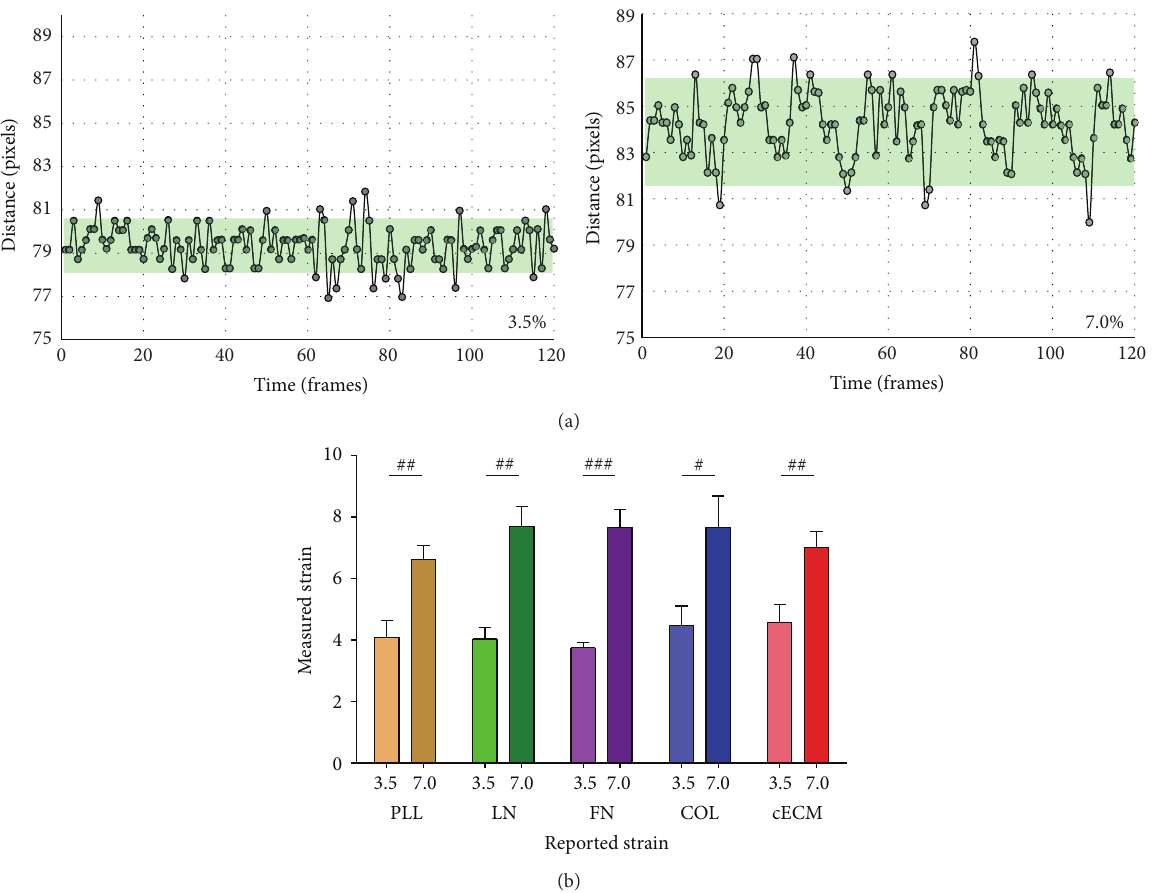
Figure 1: Cell strain. CPCs were seeded on the appropriate matrix for 6 hours. Video microscopy (19 frames per second) captured the motion of beads tethered to CPCs under cyclic 1Hz strain. (a) Representative distance tracings from CPCs cultured on cECM; programmed strain is reported on graph. (b) Strain magnitude effects on measured strain. One-way ANOVA with Tukey’s multiple comparison test; bars represent mean + SEM; # 𝑝 < 0.05 , ## 𝑝 < 0.01 , and #### 𝑝 < 0.001 ; 𝑛 = 3 –10; 3.5, 7.0: strain magnitude (%), PLL (brown): poly-L-lysine, LN (green): laminin, FN (purple): fibronectin, COL (blue): collagen I, and cECM (red): naturally derived cardiac extracellular